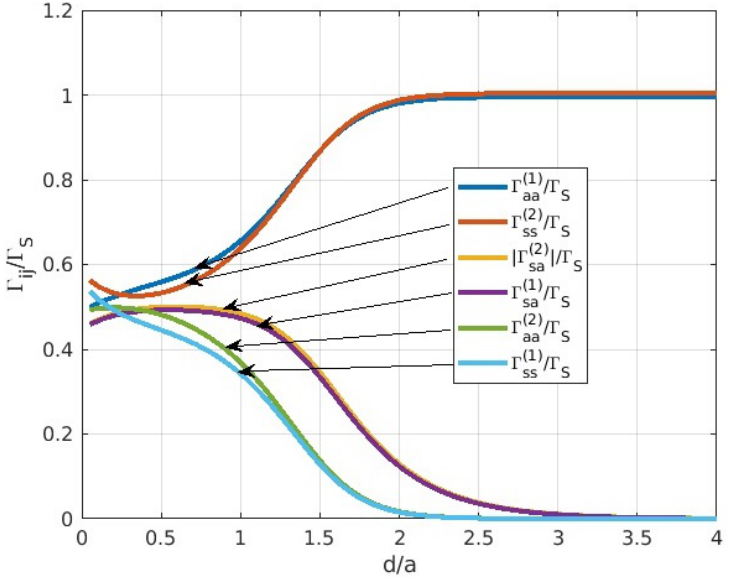
Figure 5. Plot of the overlap factors for a weakly-guiding ( v = π /2) non-symmetric slab structure as a function of spatial separation between the guides. Here, 2 d is the edge-to-edge separation between the guides and 2 a = ( w 1 + w 2 ) /2 is the average guide width, using w 1 = 7.9 µ m and w 2 = 8.1 µ m, as in Figure 4. In contrast to the case of symmetric guides, in this case the s mode tends to occupy guide ( 2 ) (the wider guide) and the a mode occupies guide ( 1 ) . As the separation increase, the corresponding overlap factors tend to the optical confinement factor, whilst all other factors tend ( 2 ) to zero. Here, the modulus of Γ sa is shown, as this factor is